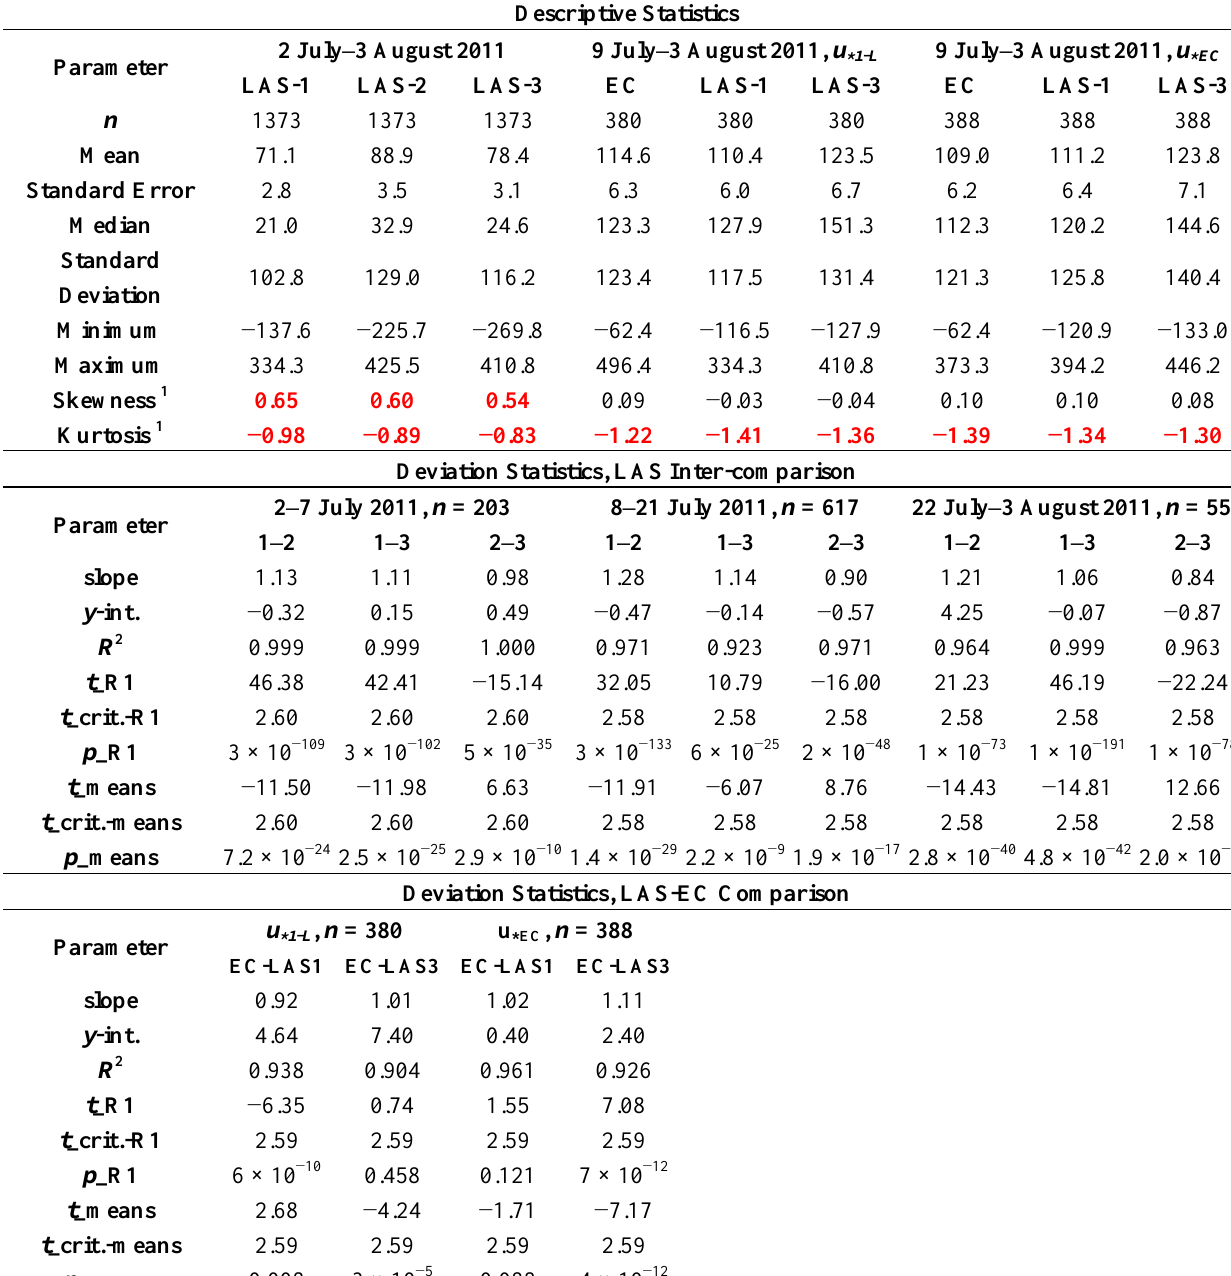
Table A1. Descriptive and deviation statistics for LAS inter-comparison and LAS-EC comparison H values (W m −2 ). t _R1 represents t statistic to test for regression slope different from 1.0; t _means represents t statistic to test for difference between period mean H values. t _crit. represents critical t value for alpha equal to 1%. p values represent probability of t values being less in magnitude than t _crit.